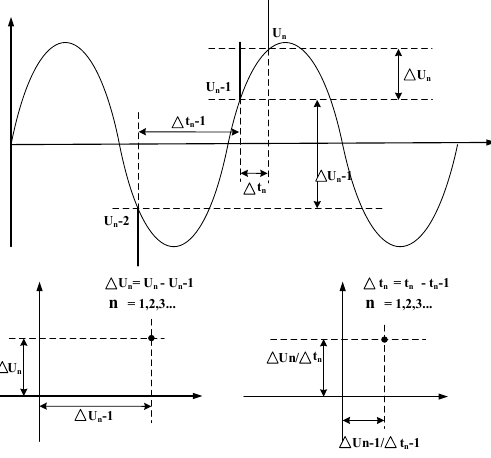
Figure 10. PSA construction for PD [119]. Reprinted from Ref